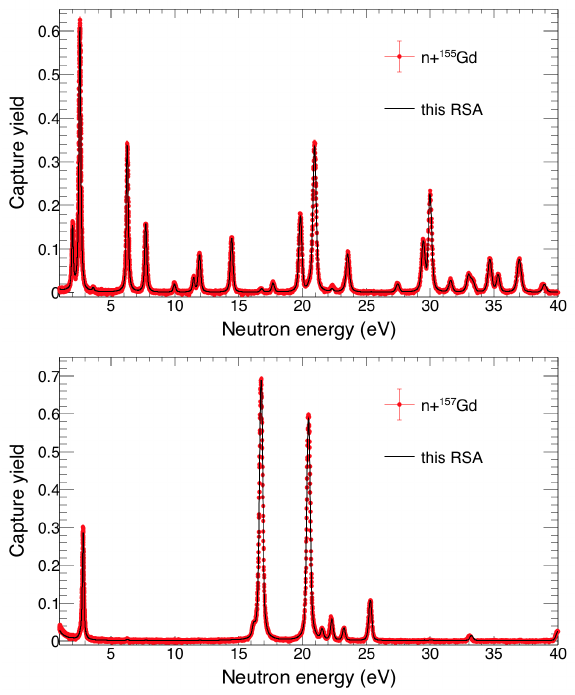
Figure 1. (Color online) 155 , 157 Gd(n, γ ) capture yields from the present experiment and results of the resonance shape analysis (RSA) in the neutron energy region from 1 to 40